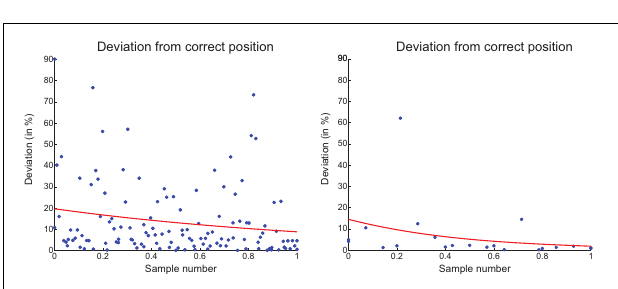
FIGURE 8 | Landing accuracy over the training from Eva (left) and Jane